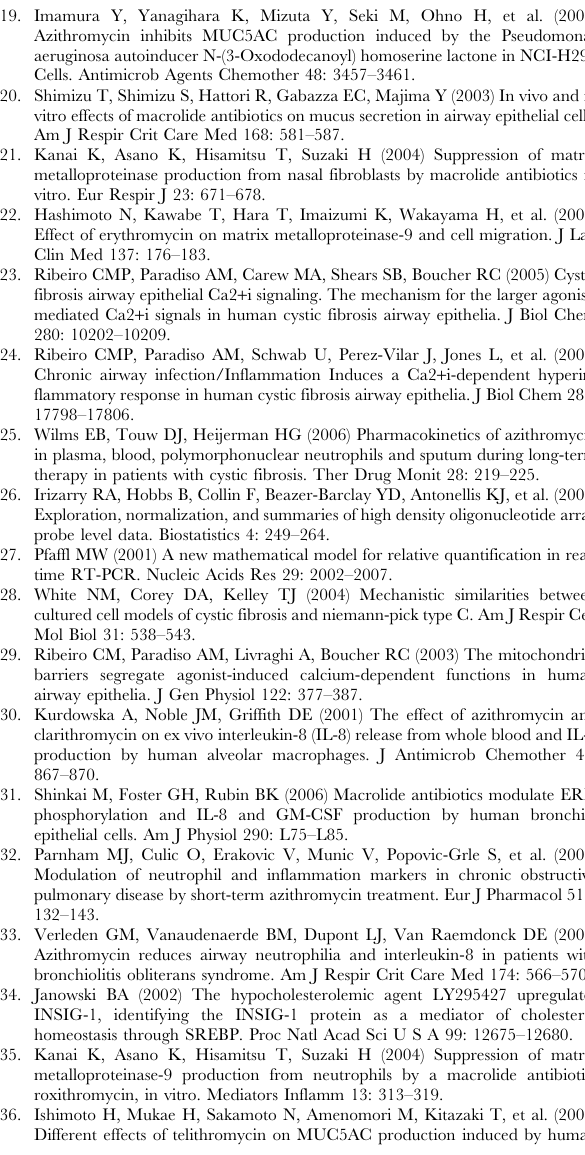
Found at: doi:10.1371/journal.pone.0005806.s002 (0.80 MB XLS) Found at: doi:10.1371/journal.pone.0005806.s003 (0.84 MB RTF) Found at: doi:10.1371/journal.pone.0005806.s004 (0.58 MB DOC) Found at: doi:10.1371/journal.pone.0005806.s005 (0.09 MB DOC) Found at: doi:10.1371/journal.pone.0005806.s006 (0.11 MB DOC)